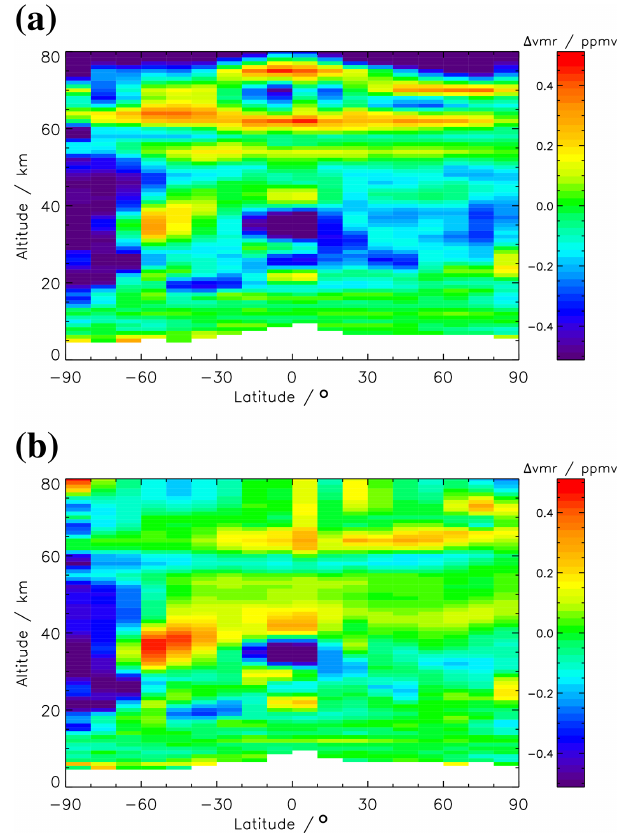
Figure 6. Differences between the means of all September data for RR and FR data. Panel (a) shows difference V5R_O3_224 minus V5H_O3_21, panel (b) V8R_O3_261 minus V8H_O3_61. See text for